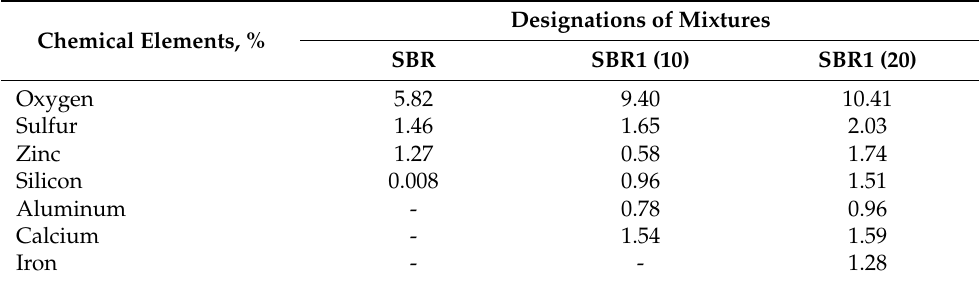
Table 7. Compositions of analyzed elastomer blends obtained by EDS analysis.